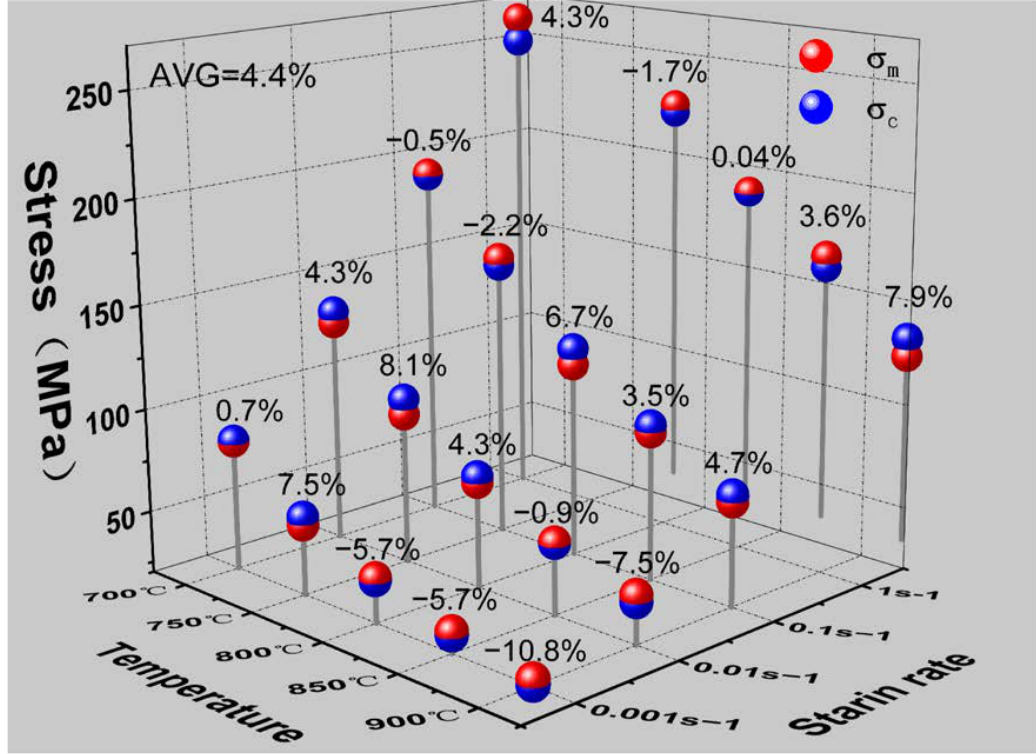
Figure 7. Correlation between the experiment and measured values of the peak stress.